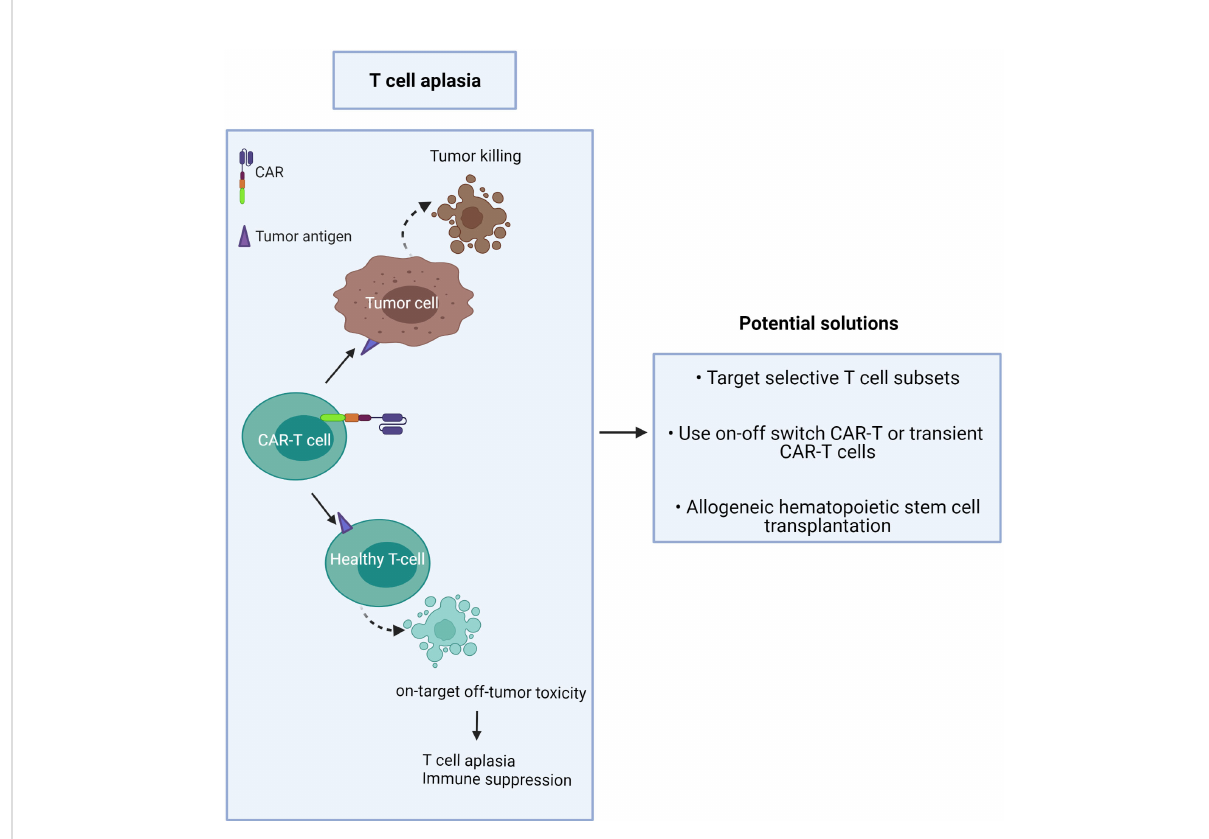
FIGURE 2 CAR-T cells induce on-target/off-tumor toxicity due to target antigen expression on healthy T